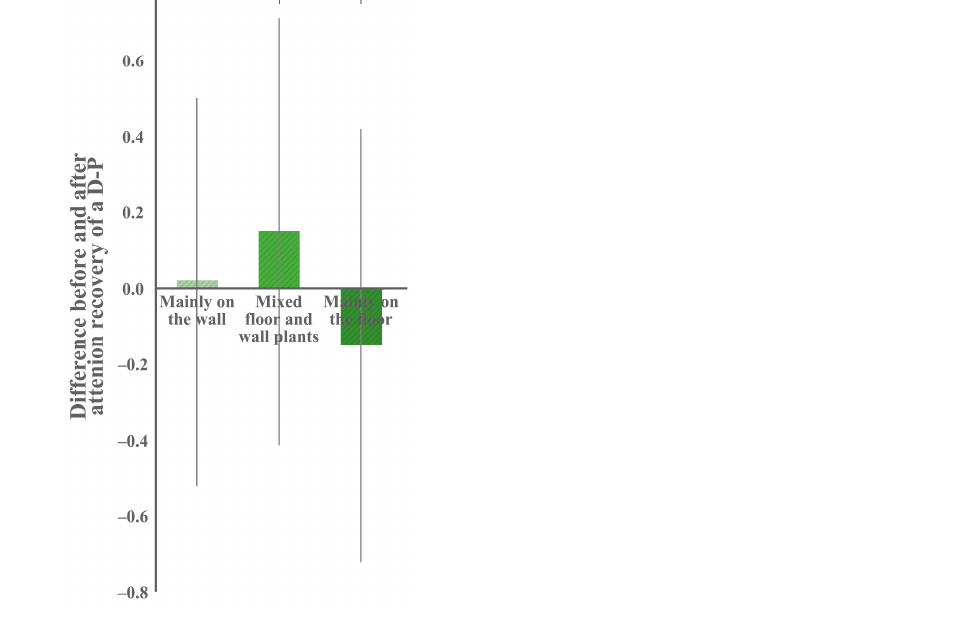
Figure 11. Main effect maps of the layout of indoor plants on attention recovery. ** Stands for statistical significance at the 0.01 level; * Stands for statistical significance at the 0.05 level; Not marked stands for no statistical significance.